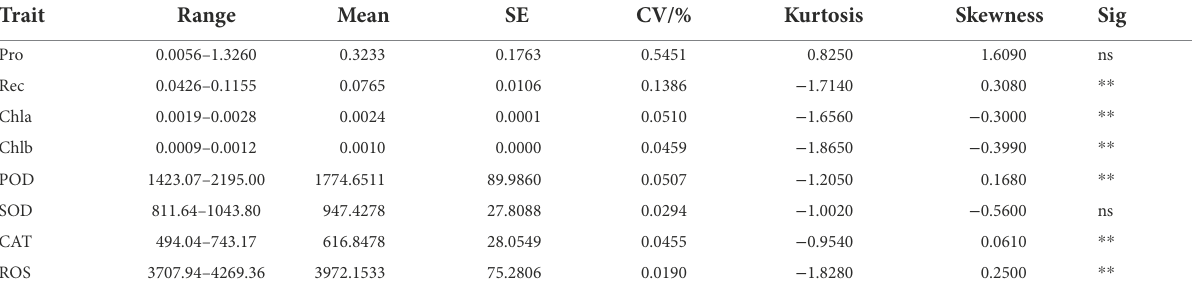
TABLE 2 Statistical description of H. virescens phenotypic data at 0 ° C.